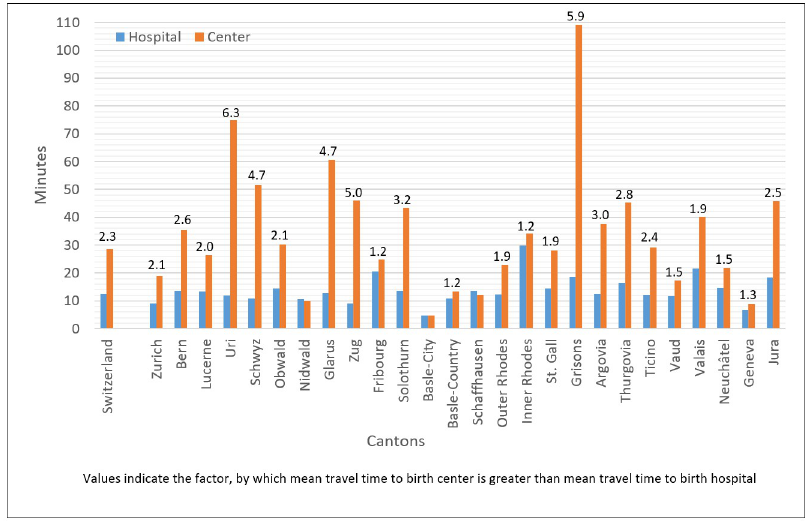
Fig 1. Mean travel times in minutes for both birth